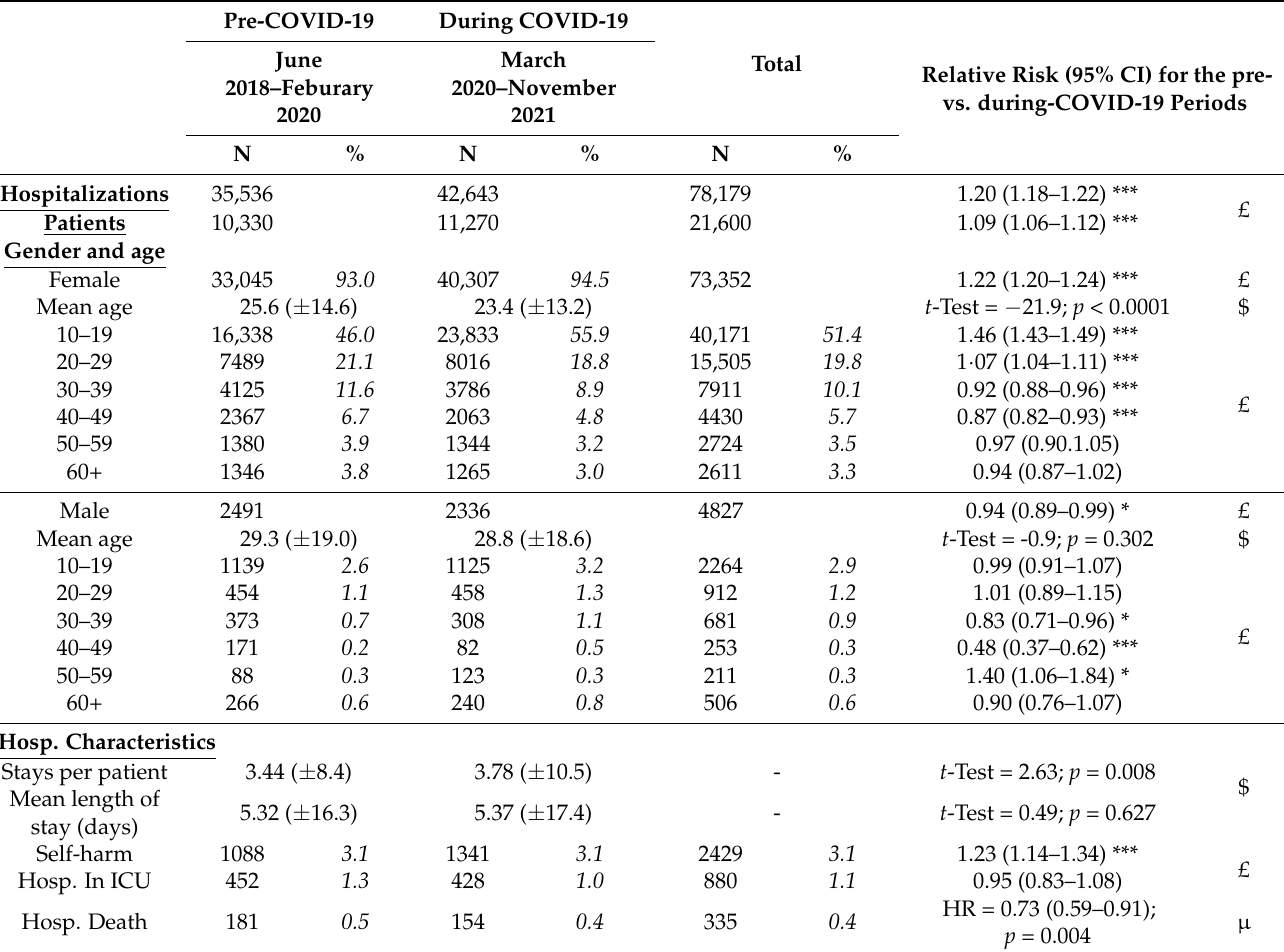
Table 1. Number of hospitalizations according to age and gender, as well as hospitalization character- istics and comparisons between before and during the COVID-19 pandemic